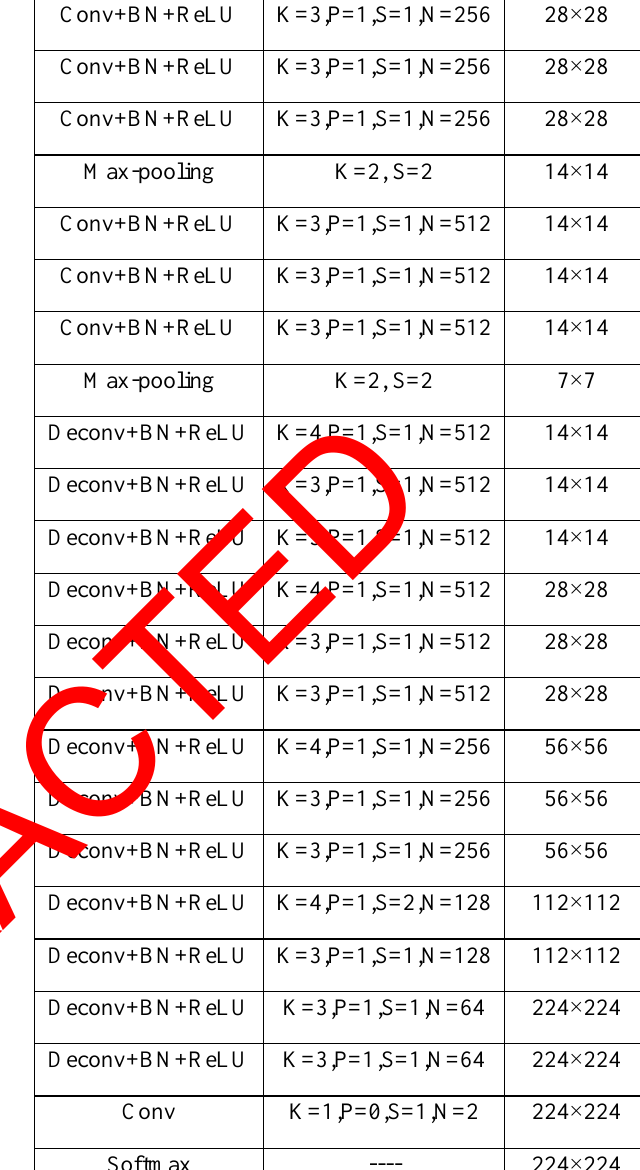
Table 1. Details of the network